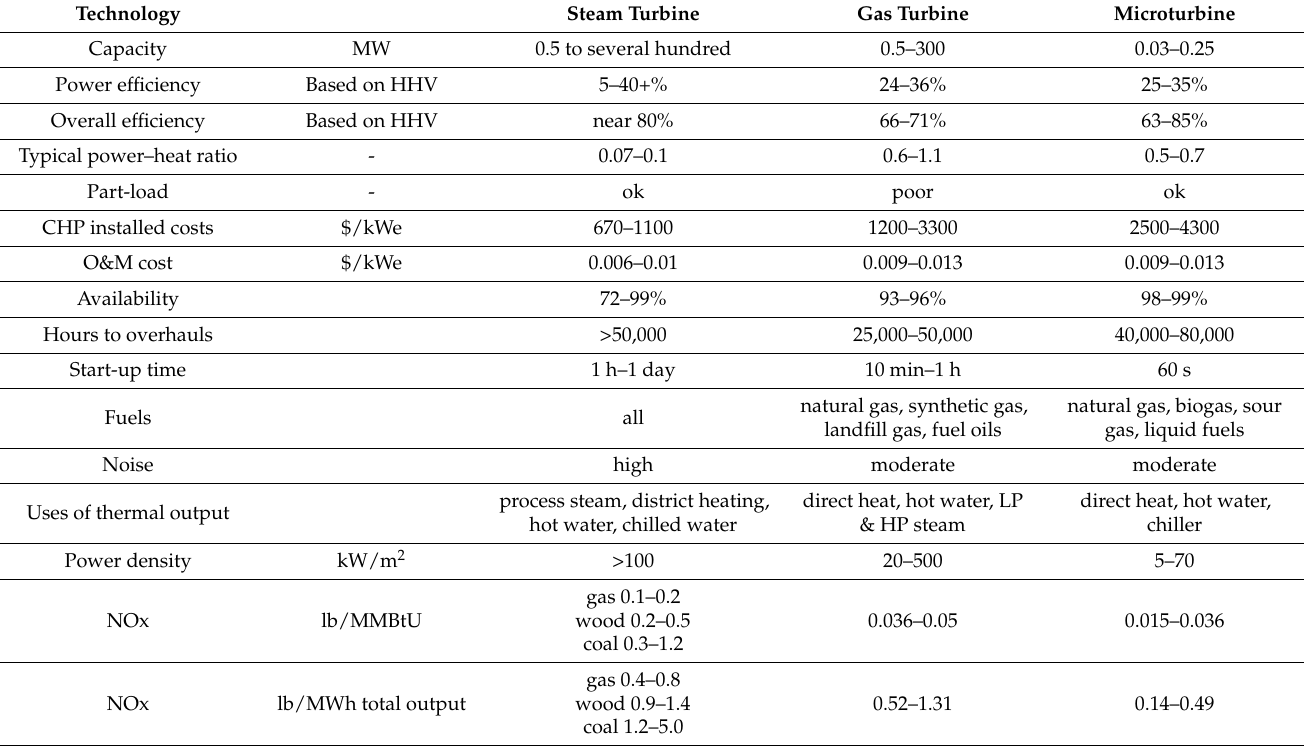
Table 3. Comparison of CHP technologies: sizing, cost, and performance parameters—part 1